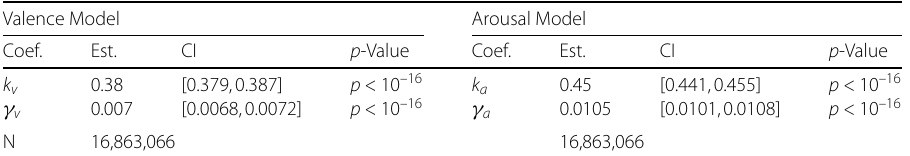
Table 1 Parameter estimates of the regression model for valence and arousal. P -values and 95% confidence intervals for parameter estimates are provided Valence Model Arousal Model Coef. Est. CI p -Value Coef. Est. CI p -Value